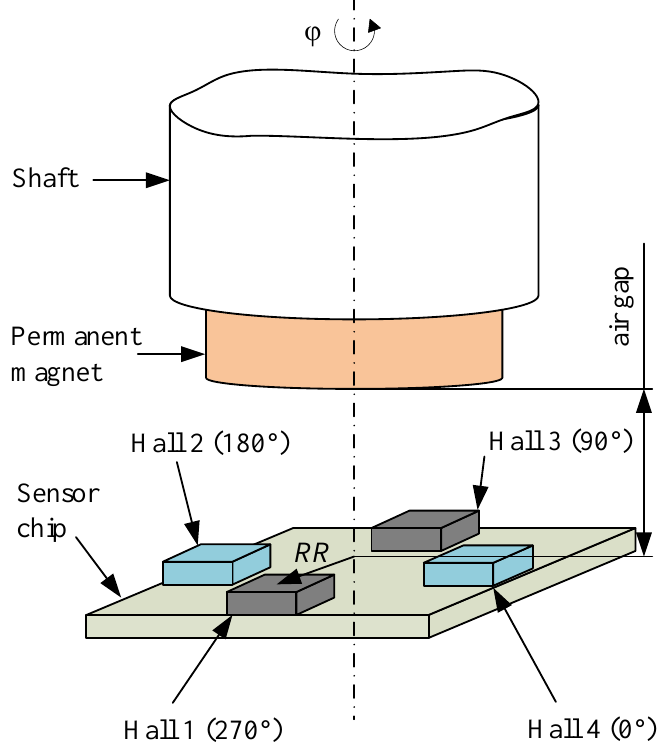
Figure 1. Schematic overview of the angle sensor